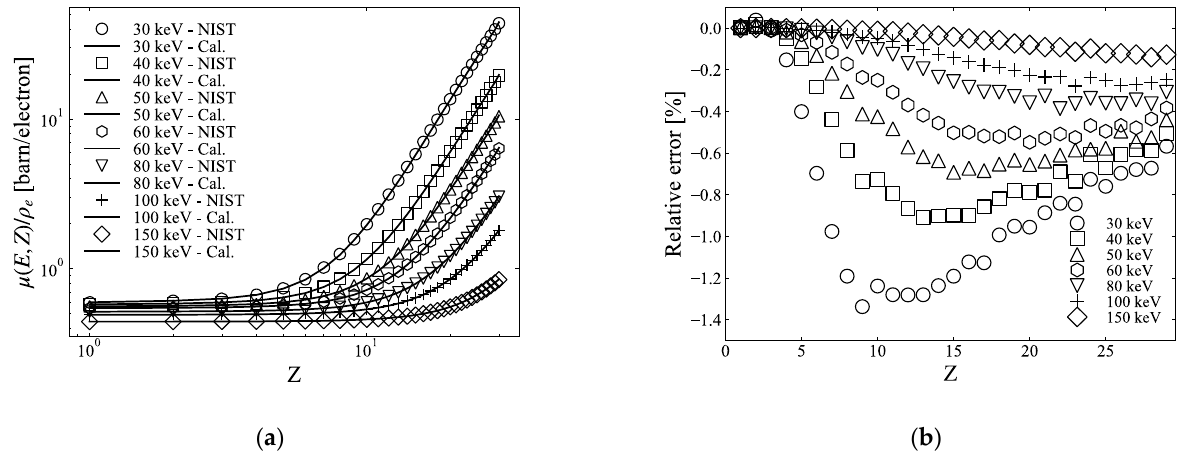
Figure 1. ( a ) µ ( E , Z ) / ρ e (solid line) from 30 keV to 150 keV of atomic numbers up to 29, calculated via two-parameter fitting methods (PFMs) using Equation (5), and corresponding NIST values (marker), ( b ) relative errors between calculated and NIST values in ( a ).